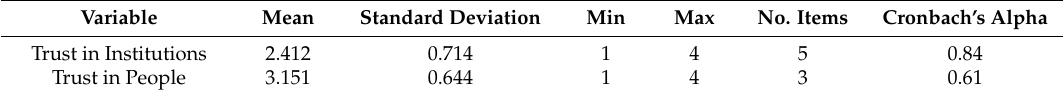
Table 3. Summary of calculated attitudinal indices.